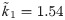
Cross section of the phase diagram.Cross section of the phase diagram in the k˜1=1.54 plane. The burst size for the red surface is r = 1 for each step to the left r is increased by 20 (as indicated by numbers in each colored tongue). The black line shows the deterministic solution.